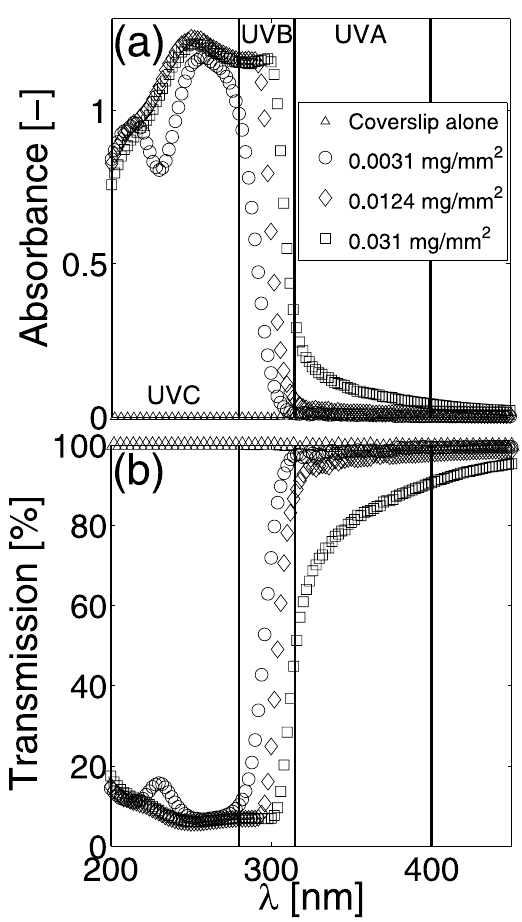
Figure 2. Surface density effects on UV absorbance and transmission. Average ( a ) absorbance and ( b ) transmission spectra of DNA films with surface densities of 0.0031 mg/mm 2 (n = 3, open circle), 0.0124 mg/ ≤ 200 450 nm. Open triangle symbols denote the average (n = 3) absorbance and transmission spectra of the optically transparent glass coverslips on which all DNA films are coated. Vertical lines delineate the UVA (315–400 nm), UVB (280–315 nm), and UVC (200–280 nm) ranges. Standard deviations in all cases are smaller than the symbol size and have not been plotted to improve visual